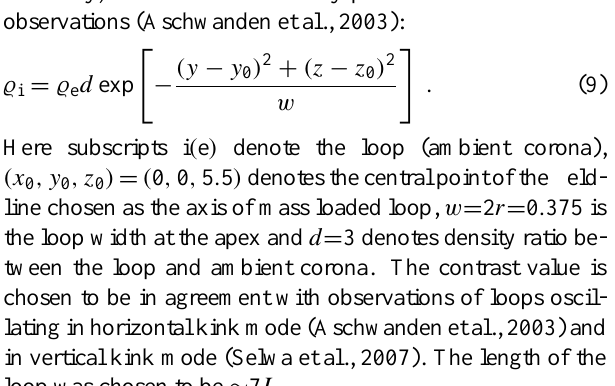
Fig. 1. Initial 3-D magnetic field configuration of the model AR with the high density loop as a flux-tube for straight (left panel) and dipole Fig. 1. Initial 3D magnetic (cid:2)eld con(cid:2)guration of the model AR with the high density loop as a (cid:3)ux-tube for straight (left panel) and dipole (right panel) fields. Spatial coordinates are measured in units of L s (right panel) (cid:2)elds. Spatial coordinates are measured in units of L s . al. (2005, 2007a) that vertical oscillations in 2D arcade loop are damped through energy leakage and con(cid:2)rmed by